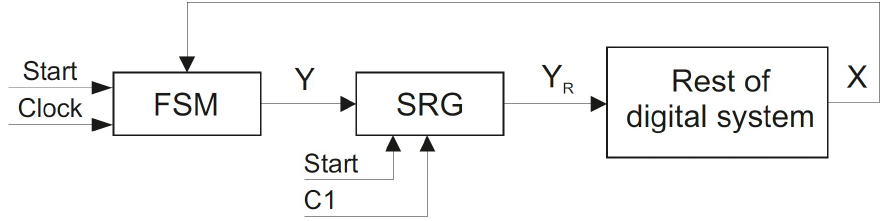
Figure 5. Interaction of FSM with the rest of a digital